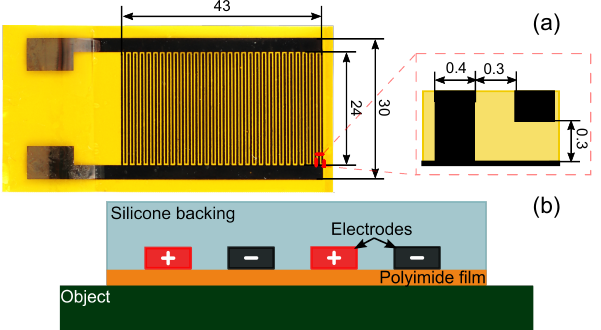
Figure 5. The electroadhesive pads used in the experiments. ( a ) Top view of the pad with the interdigitated electrode structure. All dimensions are in millimeters. ( b ) Schematic of the